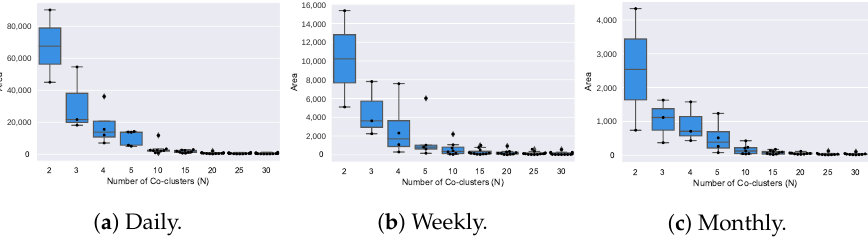
Figure 17. Size of coclusters and number of coclusters ( N ) for the spectral Coclustering of scaled daily, weekly, and monthly consumption at InfraQuinta, 2017.